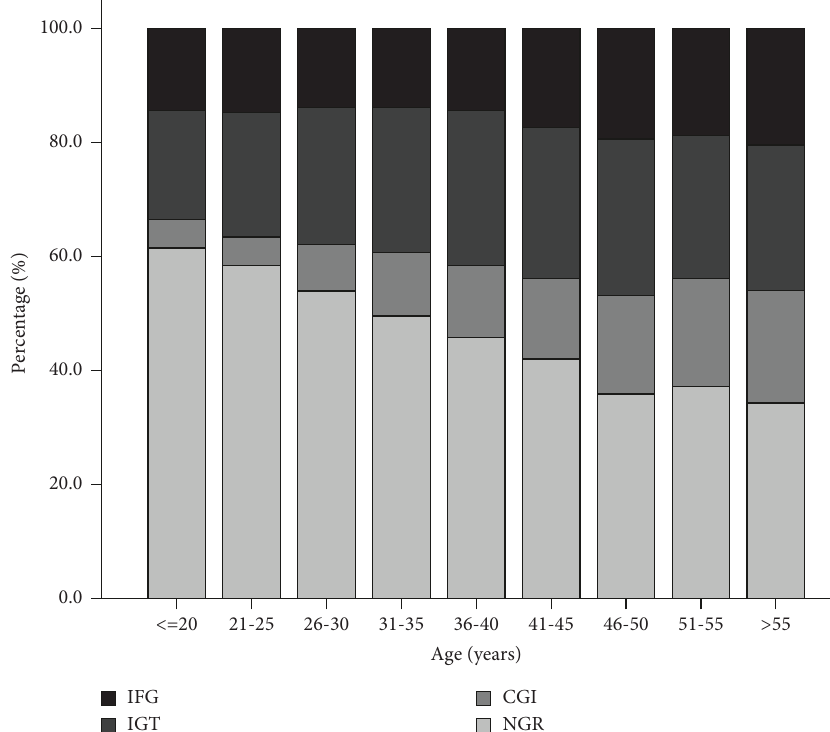
Figure 1: Te prevalence of IFG, IGT, and CGI in participants according to diferent categories of age. IFG, impaired fasting glucose; IGT, impaired glucose tolerance; CGI, combined glucose intolerance; NGR, normal glucose